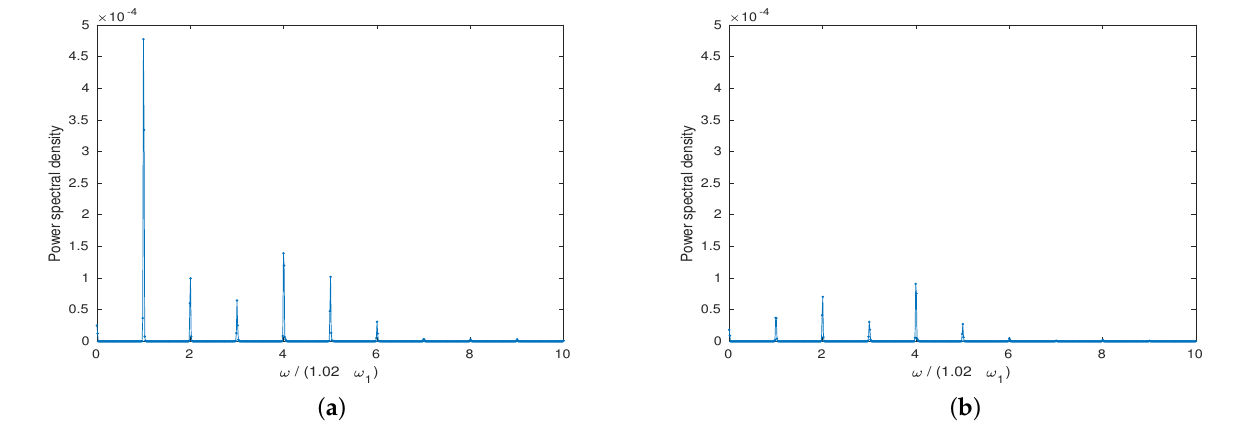
Figure 13. The frequency spectrum of coupled surge and sway cases under different excitation frequencies:. excitation frequency : ω / ω 1 = 1.02, excitation amplitude : 0.001 m (surge); excitation frequency : ω / ω 1 = 1.02, excitation amplitude : 0.002 m (sway). ( a ) corner A; ( b ) corner B.